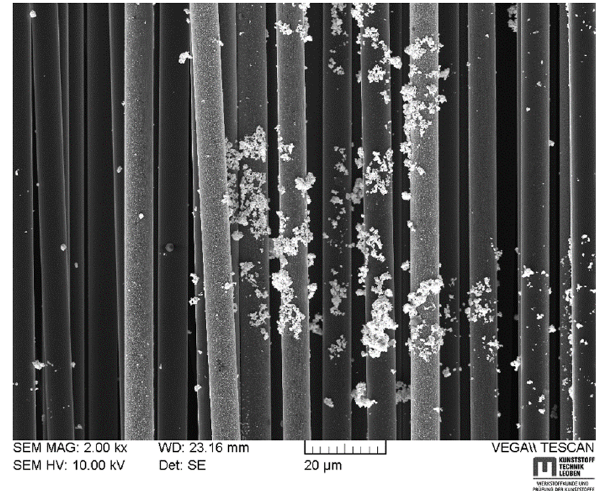
Figure 15: Ag - modi fi ed carbon fi bers using 30 V and 10 min.